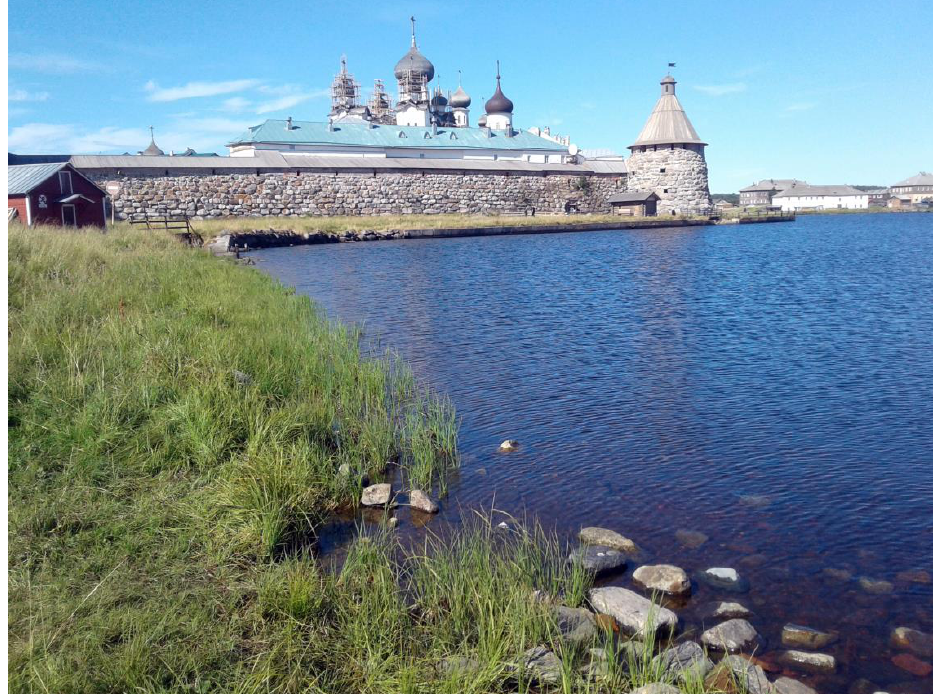
Fig. 3. Arkhangelsk Region, Solovetskii Island, Svyatoe Lake at the Monastery, a typical habitat of Campsicnemus , Dolichopus and Sympycnus species, August 2018